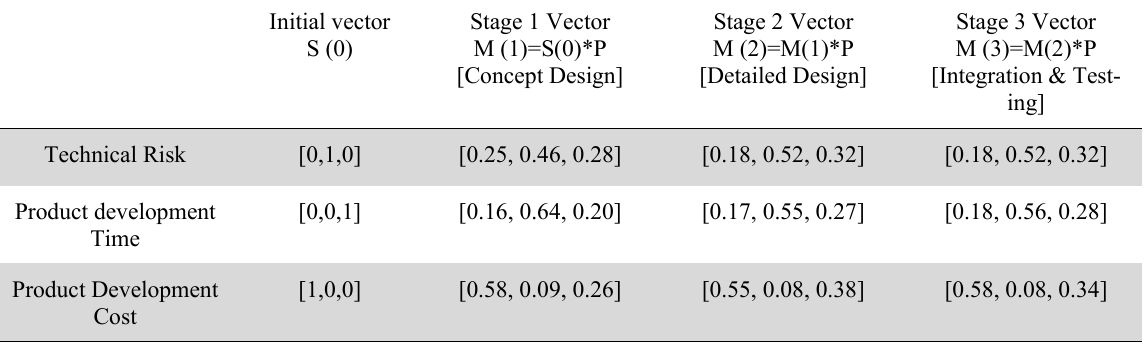
Probability of different risk factors in initial NPD stages Initial vector